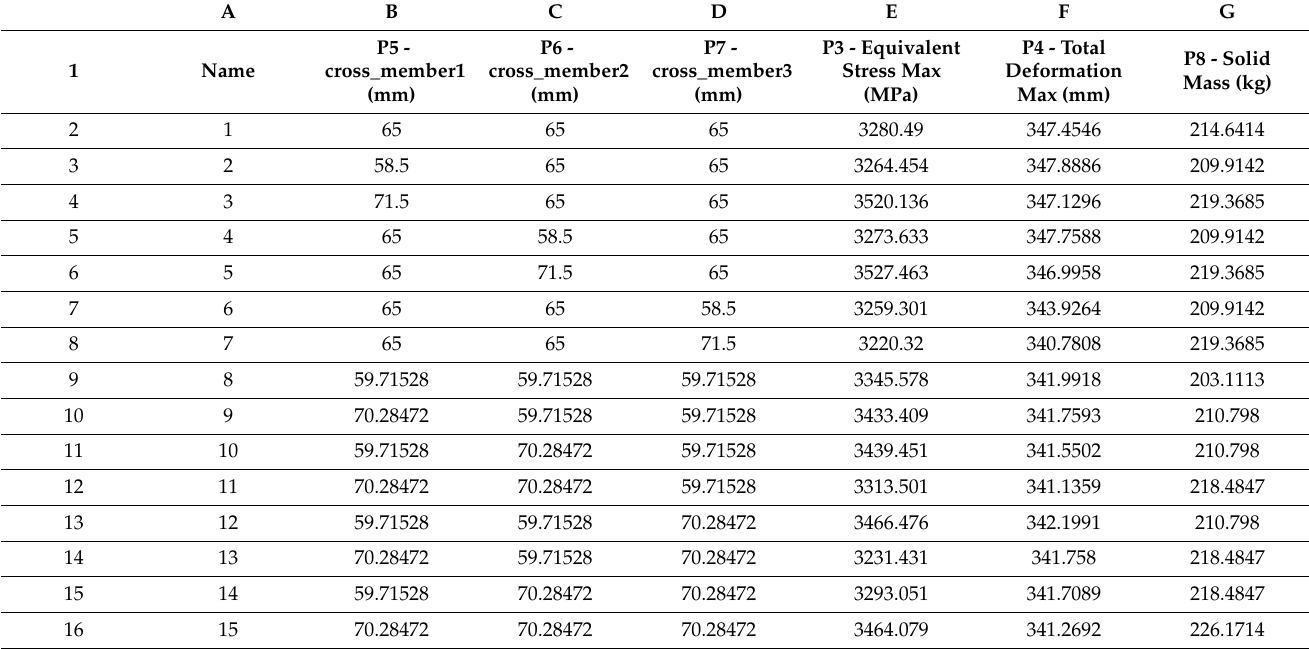
Table 3. DOE table for CCD